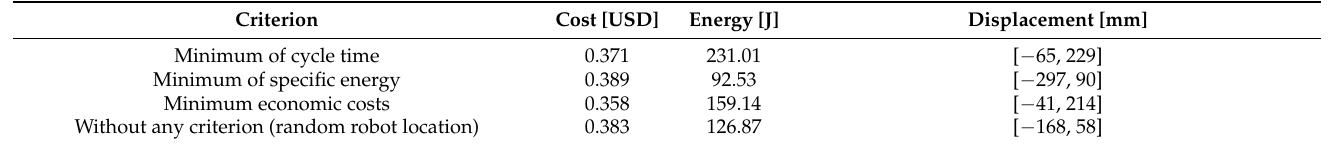
Table 10. Results for minimisation of economic cost of single transport